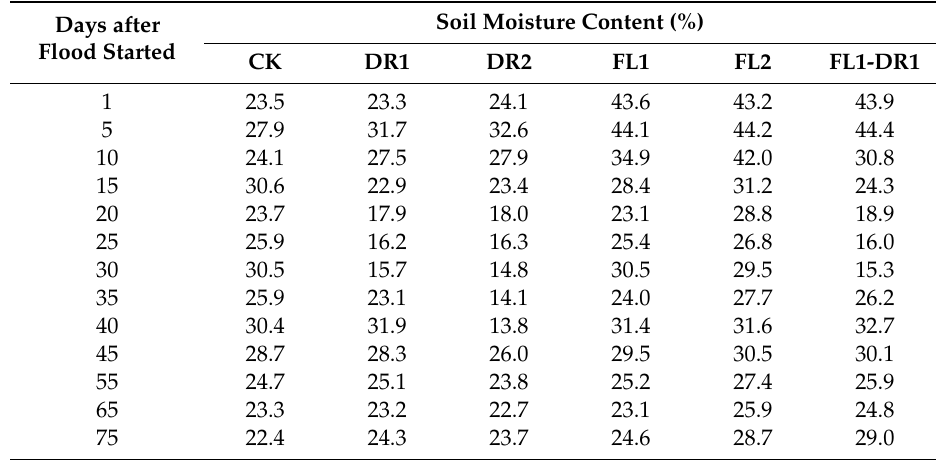
Table 2. Soil moisture content of di ff erent treatments from water stress beginning to harvest. Days after Flood